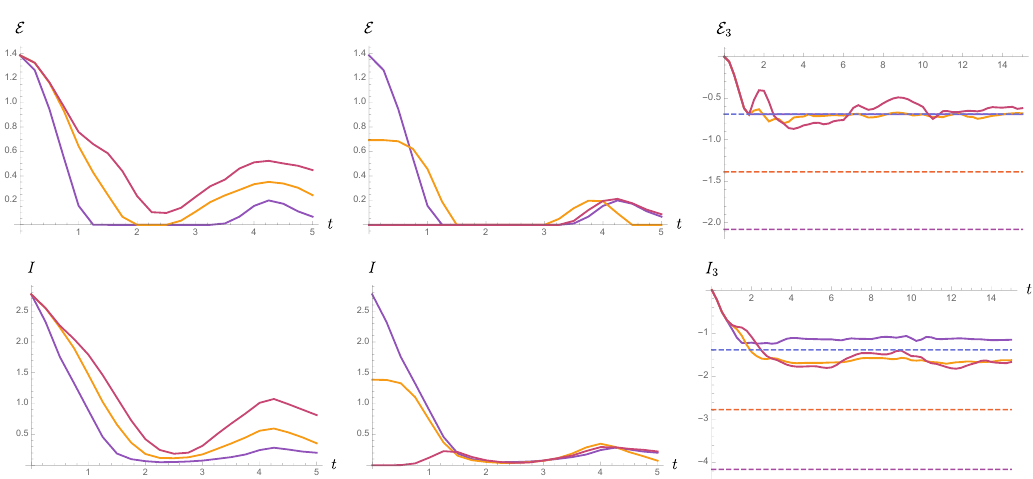
Figure 12 . The operator entanglement for the integrable spin chain (3.47) with g = 1 : 0, h = 0. We use the same con(cid:12)gurations as (cid:12)gure